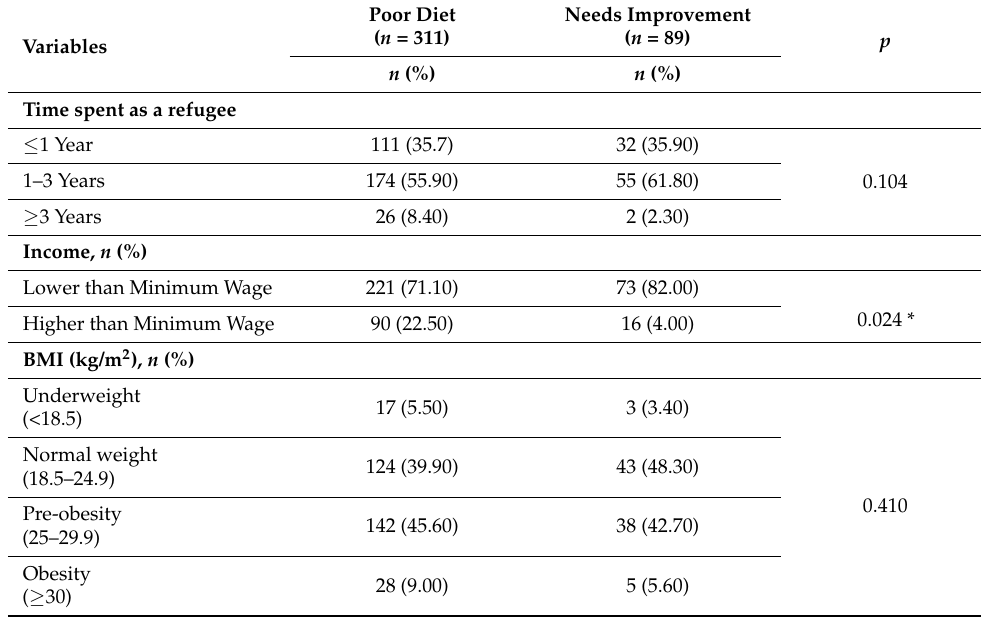
Table 4. Relationship between the nutritional status of the refugees according to HEI-2010 and various